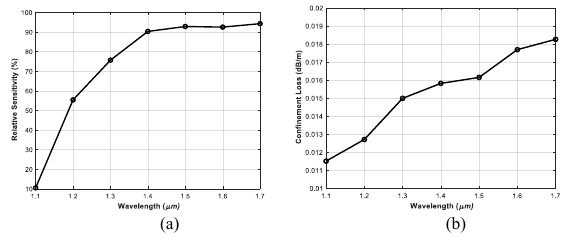
FIGURE 3. a) The relative sensitivity and b) the confinement loss of Proposed PCF for wavelengths around 1.1 μ m to 1.7 μ m.